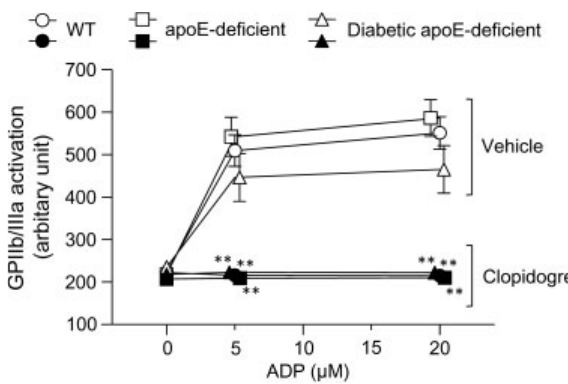
Fig. 5 Effects of clopidogrel on platelet expression of ADP-induced activated GPIIb/IIIa expression. Clopidogrel (10 mg/kg/d) or vehicle was administered orally once daily for 5 days to wild-type (WT), apoE-de fi cient, and streptozotocin-induced diabetic apoE-de fi cient mice, and blood collected 2 hours after the last dose. Ex vivo expression of activated GPIIb/IIIa on platelets induced by 5 and 20 μ M ADP was assessed using a fl ow cytometer. In the vehicle groups, ADP stimulation resulted in a signi fi cant increase in the expression of activated platelet GPIIb/IIIa compared with no agonist ( p < 0.01 for diabetic apoE-de fi cient mice, p < 0.001 for other groups). The results are presented as mean (cid:4) SE ( n ¼ 10). (cid:5)(cid:5) p < 0.01 versus corresponding vehicle group (Student ’ s t -test).